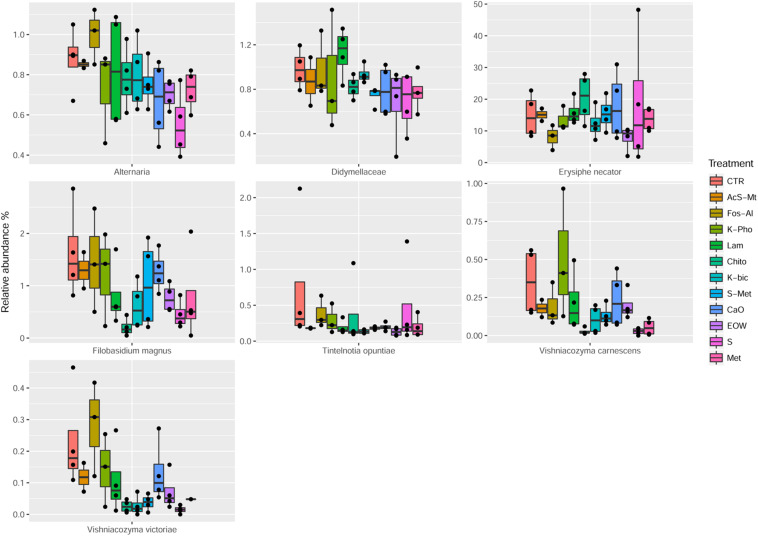
Boxplots showing the relative abundance at species or genus level of the OTUs, differentially abundant based on Wilcoxon matched pairs test, in grape samples. Treatment descriptions are reported in Table 1.